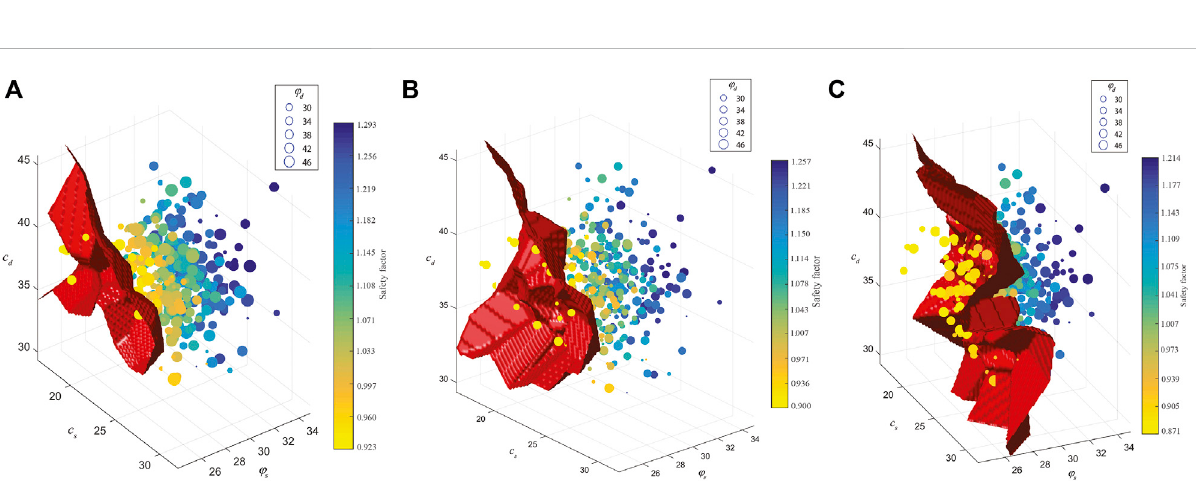
FIGURE 11 Safety factors of three sliding surfaces with 400 training samples. (A) 1st sliding surface (B) 2nd sliding surface (C) 3rd sliding surface.